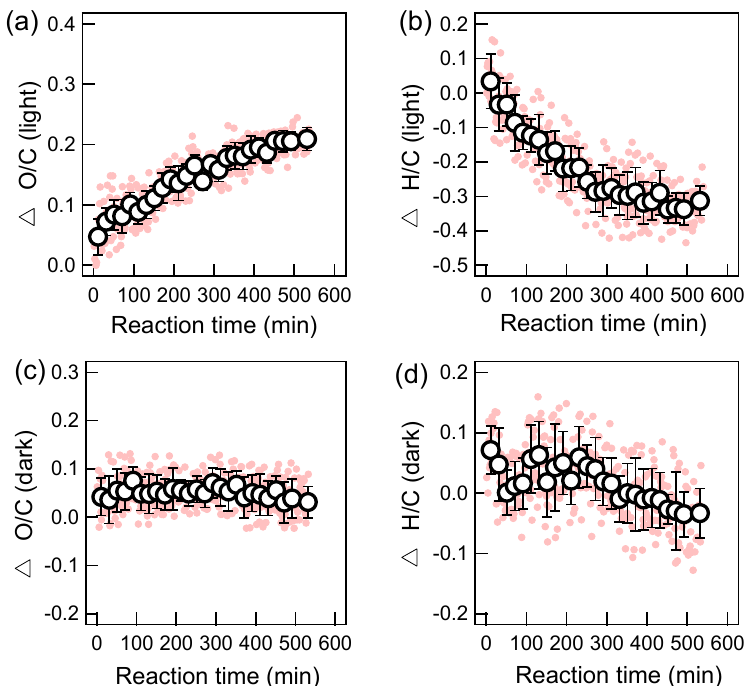
Figure 4. Time series of changes of oxygen-to-carbon (O / C) and hydrogen-to-carbon (H / C) during OH-mediated photochemical oxidation ( a , b ) and dark oxidation ( c , d ) (note in each plot, the first pink point is zero; the first black circle is the average of the first 7 pink points, namely the 10.5 min average value; other black circles are average values of every 12 pink points, namely the 18 min average; the error bar is one standard deviation).